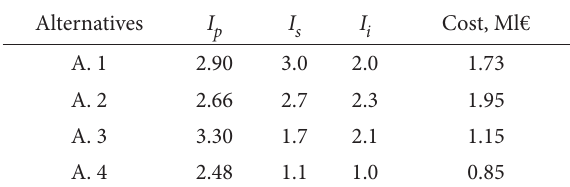
Table 2. Performance of each alternatives compare to I p index